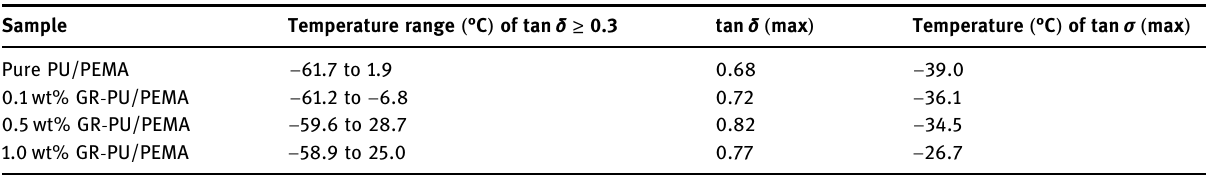
Table 2: Characteristic DMA data of GR - PU/PEMA IPN composites